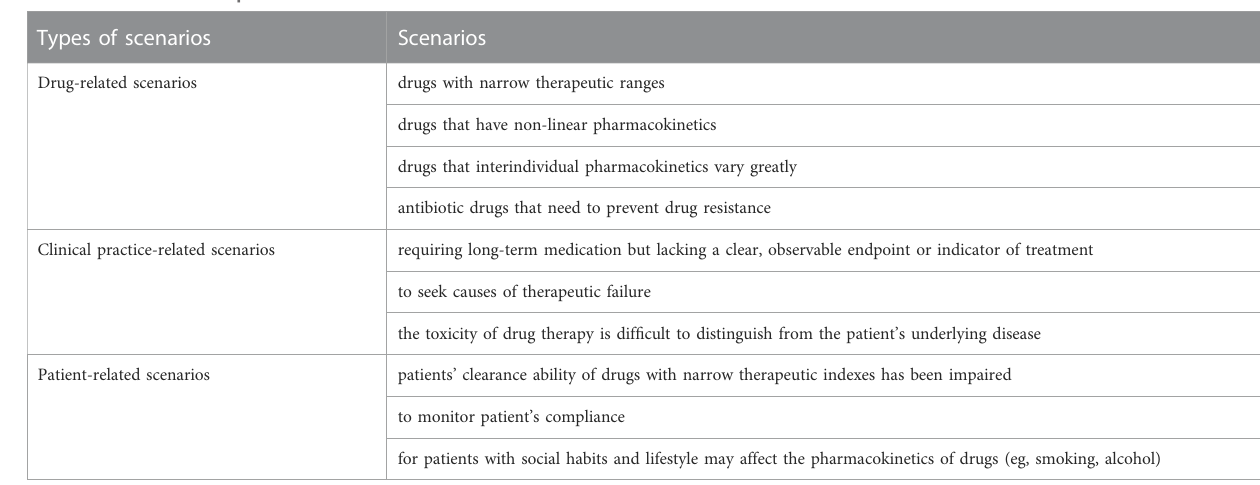
TABLE 4 Scenarios that require TDM.